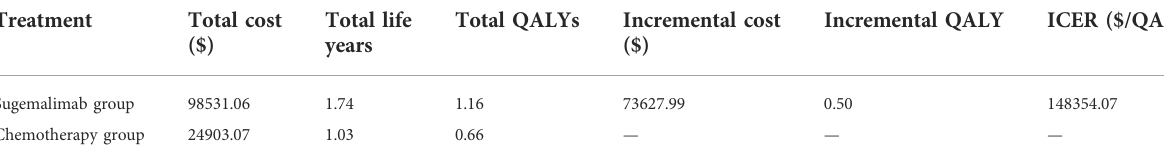
TABLE 3 The base results of the cost-effectiveness analysis. Treatment